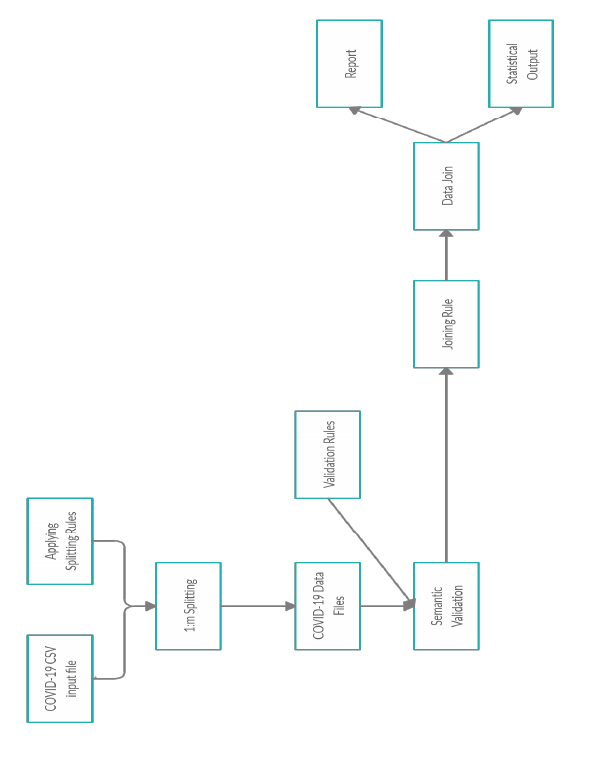
Figure 8. Excecution Time Analysis of posposed ETL model while increasing number of records